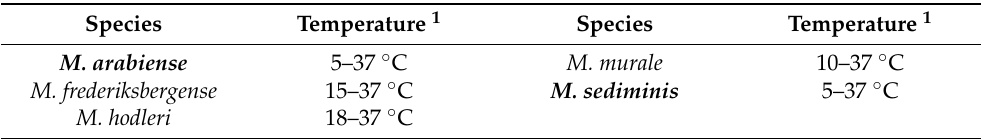
Table 1. Psychrophilic nontuberculous